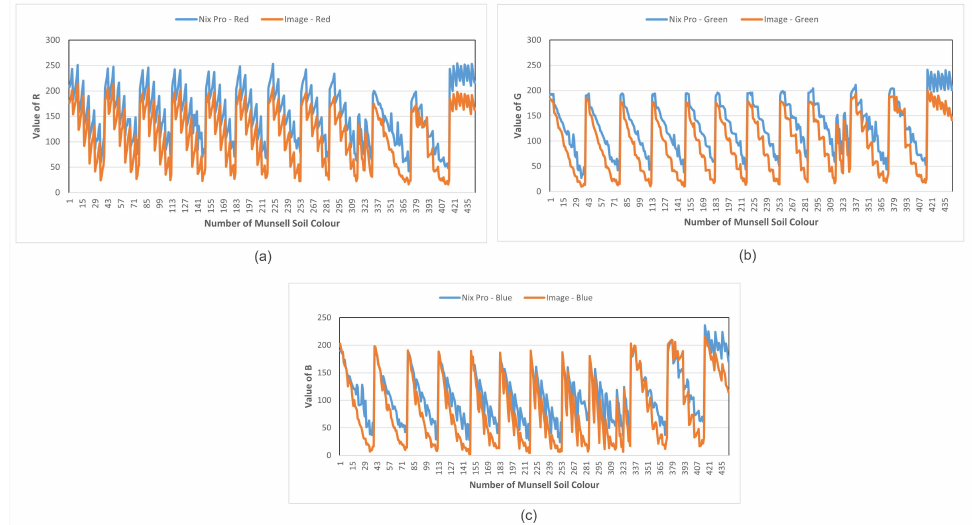
Figure 1. Colour discrepancies between the Nix Pro and Samsung smartphone provided pixel intensity of RGB colour model. The colour components are ( a ) Red colour, ( b ) Green colour, and ( c ) Blue